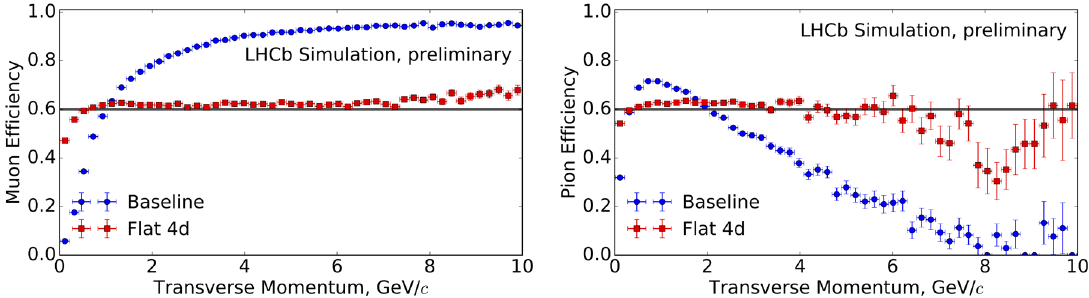
Figure 3. Dependence between Flat 4d model e ffi ciencies and particle transverse momentum for each particle type. The curves correspond to the same global signal e ffi ciency of